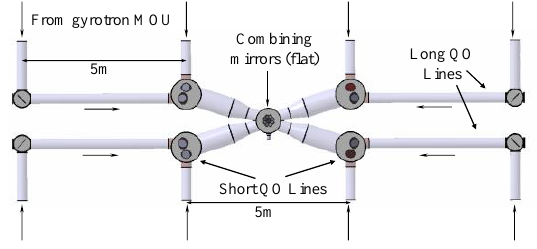
Fig. 4. Top view of the 3D CAD model of SBTL arrangement for one cluster in the ECRH